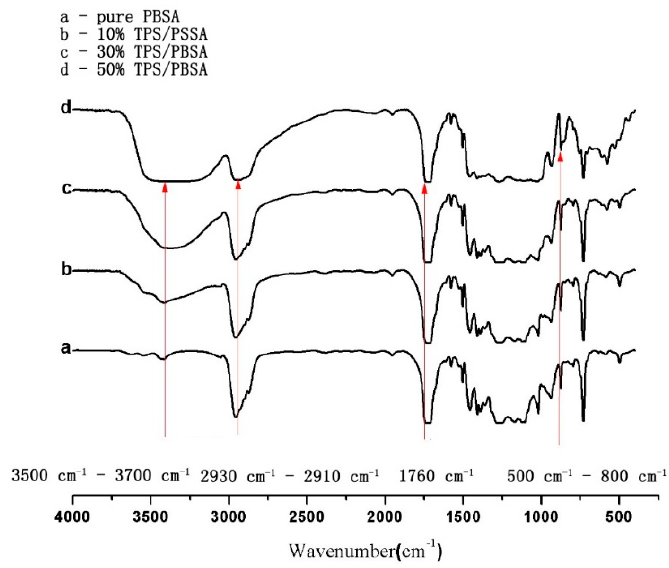
Figure 1. FTIR spectra of the TPS/PBSA blend.